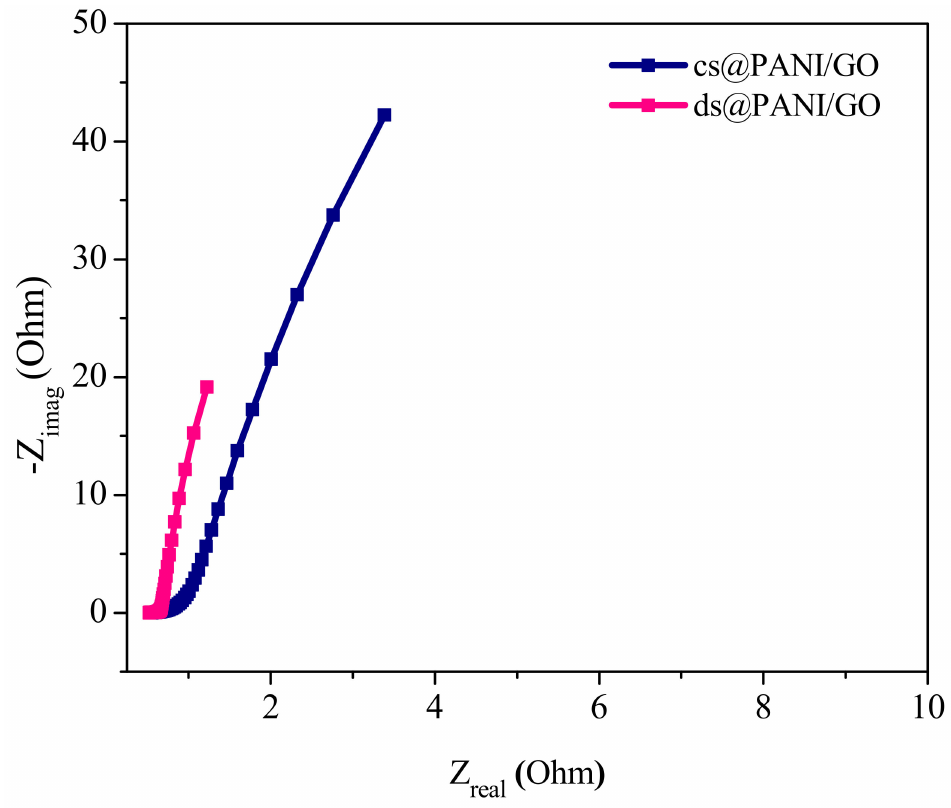
Figure 8. Nyquist plots of ds@PANI / GO and cs@PANI /